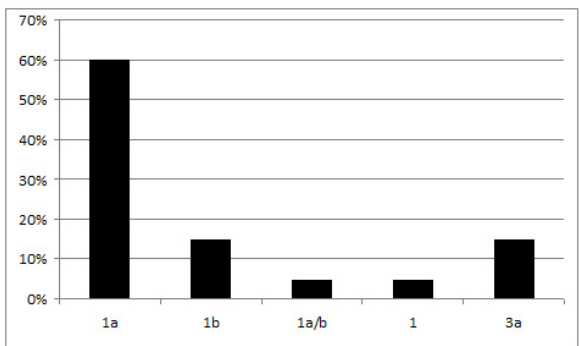
Figure 1. Distribution of blood samples obtained from prisoners according to HCV genotypes in Campo Grande, Mato Grosso do Sul state, Brazil, 2010 (n =